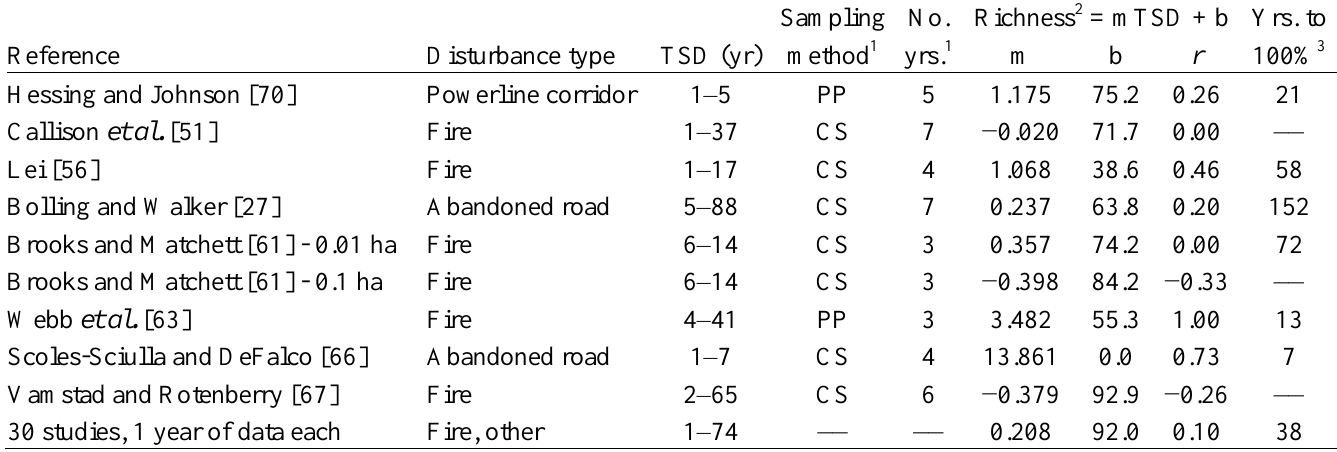
Table 2. Relationship of time since disturbance (TSD) and perennial plant species richness in the Mojave and Sonoran Deserts of the American